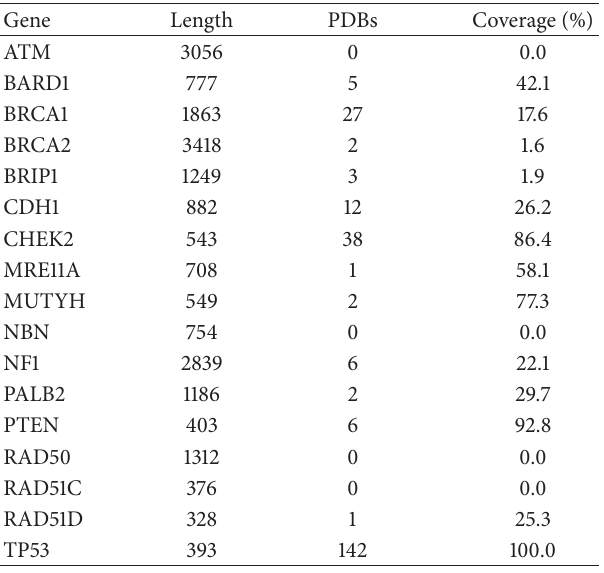
∗ Gene lengths and coverage are tabulated from the Universal Protein Resource (Uniprot) [4] and the Research Collaboratory for Structural Bioinformatics (RCSB) [5] databases. The list of genes is taken from the BreastNext